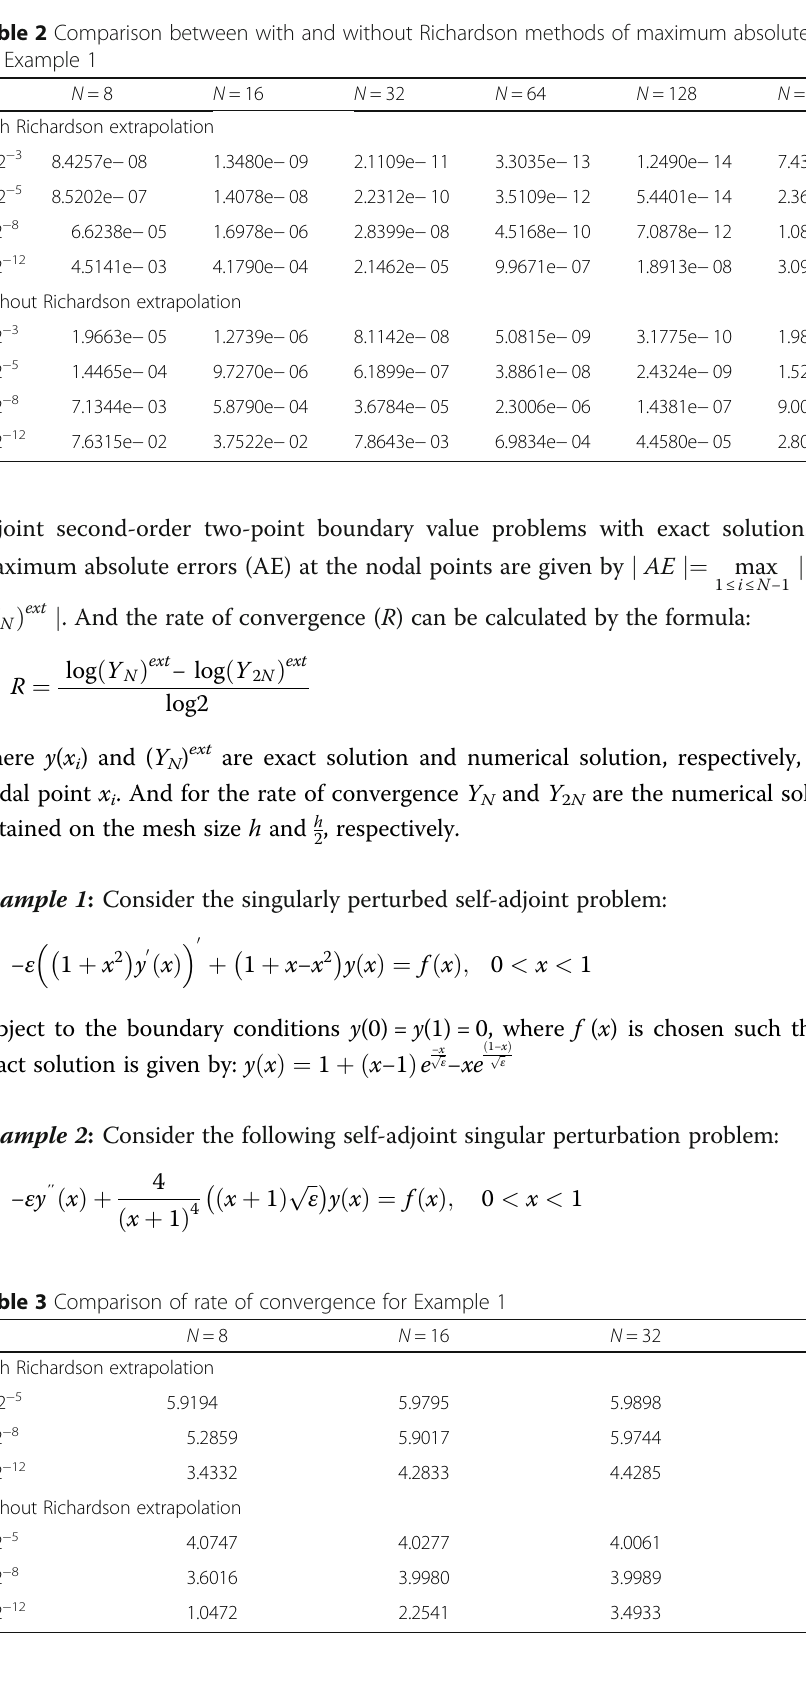
Table 2 Comparison between with and without Richardson methods of maximum absolute errors for Example 1 ε N = 8 N = 16 N = 32 N = 64 N = 128 N = 256 With Richardson extrapolation